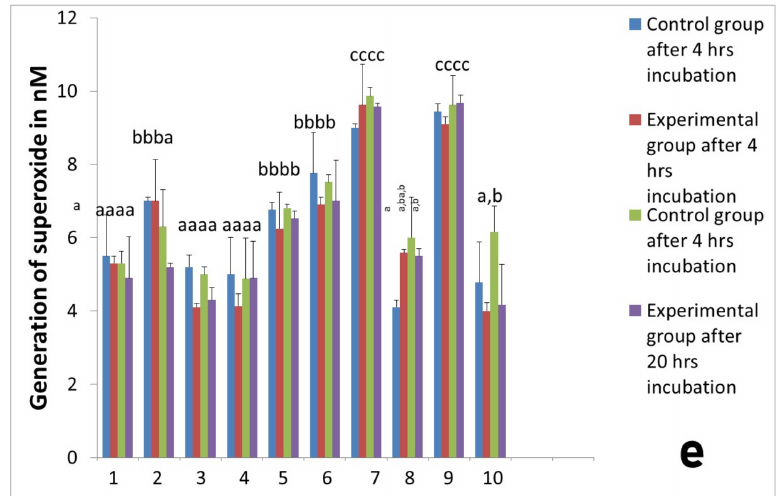
Figure 4. The response of neutrophils isolated 2 h after implantation with different PRP-derived products with or without additional stimulation with LPS. Cultures were incubated for 4 h or for 20 h at 37 ◦ C and 5% CO 2. Data present mean values ± SE of at least three replicates for each bar. The neutrophil response was assessed with respect to: ( a ) elastase release from neutrophils, ( b ) MPO release, ( c ) ALP release, ( d ) NO generation, ( e ) superoxide generation. Values marked with different letters differed significantly ( p < 0.05). Legends: 1—neutrophil without stimulation, 2— after stimulation LPS, 3—after stimulation PPP from L-PRP, 4—after stimulation PPP from PURE PRP, 5—after stimulation PPP from L-PRP with LPS, 6—after stimulation PPP from PURE PRP with LPS, 7—after stimulation L-PRP, 8—after stimulation PURE PRP, 9—after stimulation L-PRP with LPS, 10—after stimulation PURE PRP with LPS.